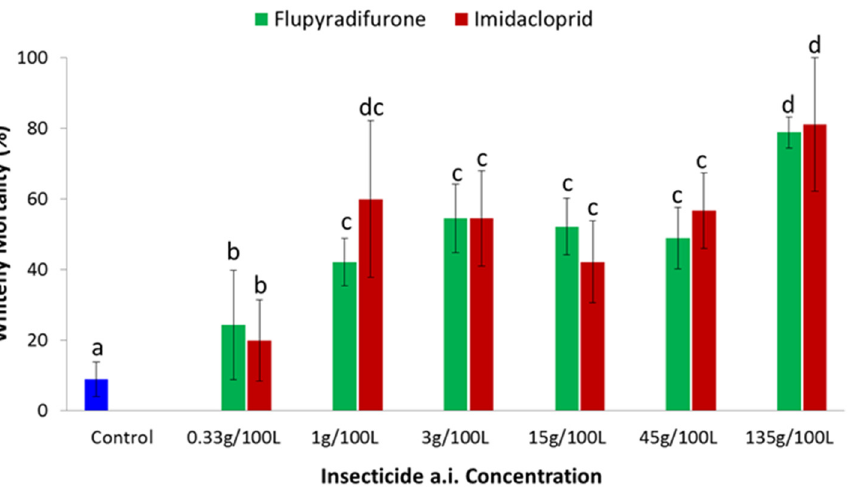
Figure 2. Mortality of adult B. tabaci 24 h post-treatment with varying concentrations of imidacloprid and flupyradifurone in comparison to control in the leaf disc assay (Means ± SE). Means with the same letter are not significantly different ( p < 0.05, Tukey–Kramer test).